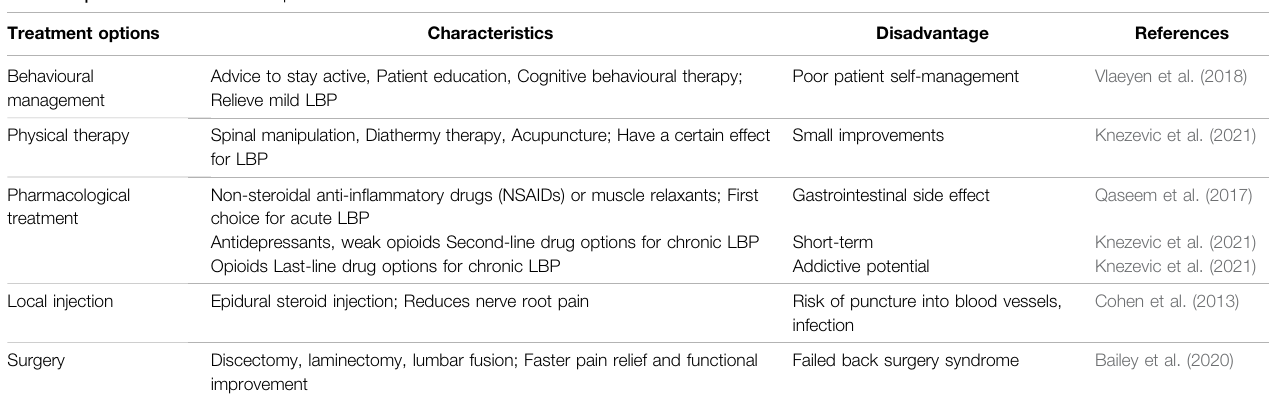
TABLE 1 | Conventional treatment options for